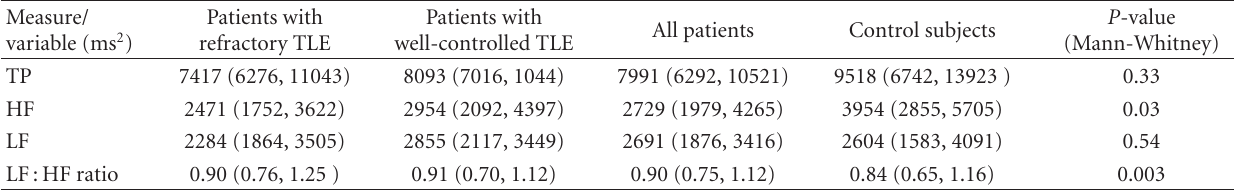
Table 2: Heart rate variation at rest in patients with temporal lobe epilepsy (TLE) and the control subjects. The P -value presents the di ff erences between all patients and the control subjects.